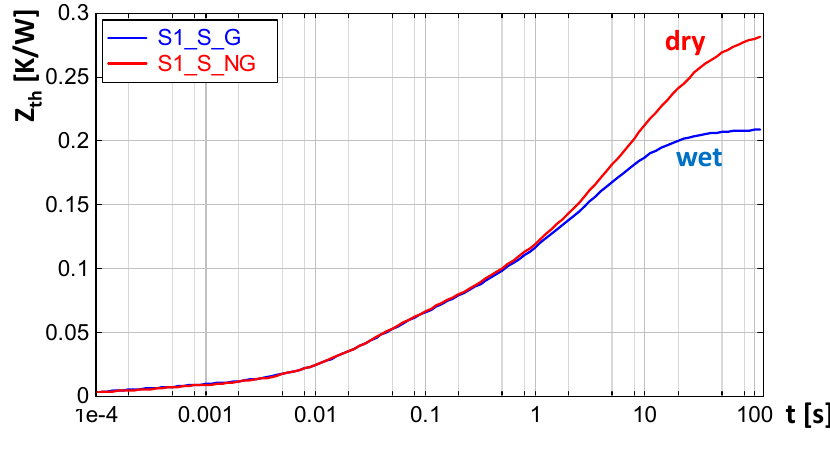
Figure 15. Z th curves calculated from Figure 14